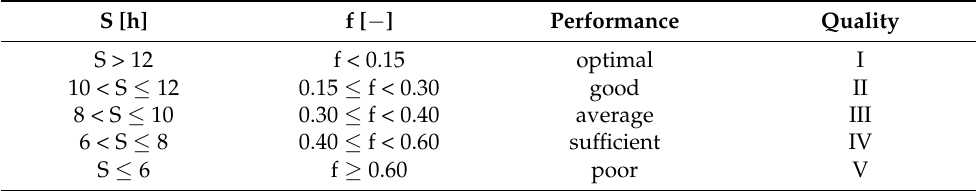
Table 4. Reference values of time shift S and decrement factor f for opaque